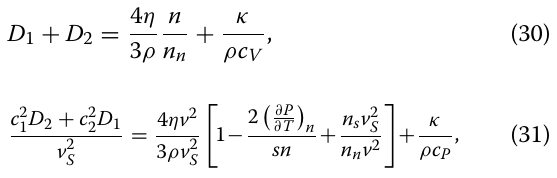
Fig. 10 a The measured first and second sound velocities as a function of the reduced temperature T / T 1 D experimental results from different methods of taking the time derivative of the pulse position of sound wave (i.e., through a polynomial fit or through analyzing subsets of nine adjacent profiles). The green dashed line for first sound velocity is the theoretical prediction c 1 = b Temperature dependence of the reduced 1D superfluid fraction n s 1 / n 1 . The grey-shaded area indicates the uncertainty range of the superfluid phase transition. From Ref.